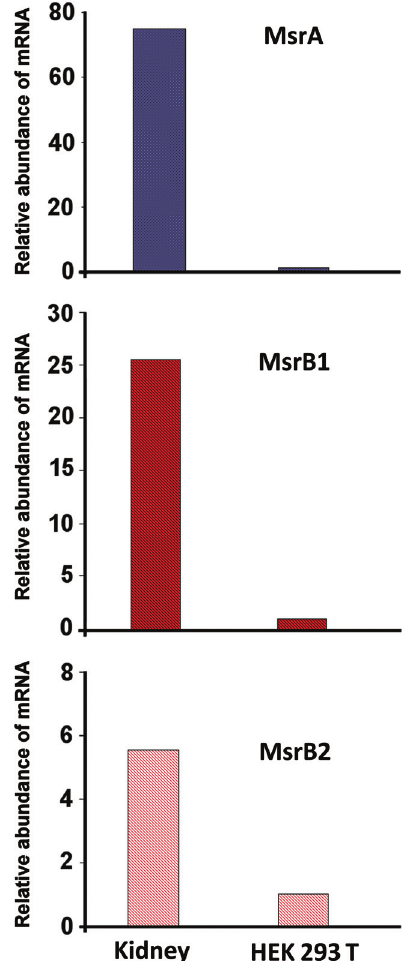
Figure 1. Levels of MsrA, MsrB1, and MsrB2 transcripts in human kidney and HEK 293T cells, analyzed by qRT-PCR. The mRNA levels of the three proteins were normalized over the levels of GAPDH